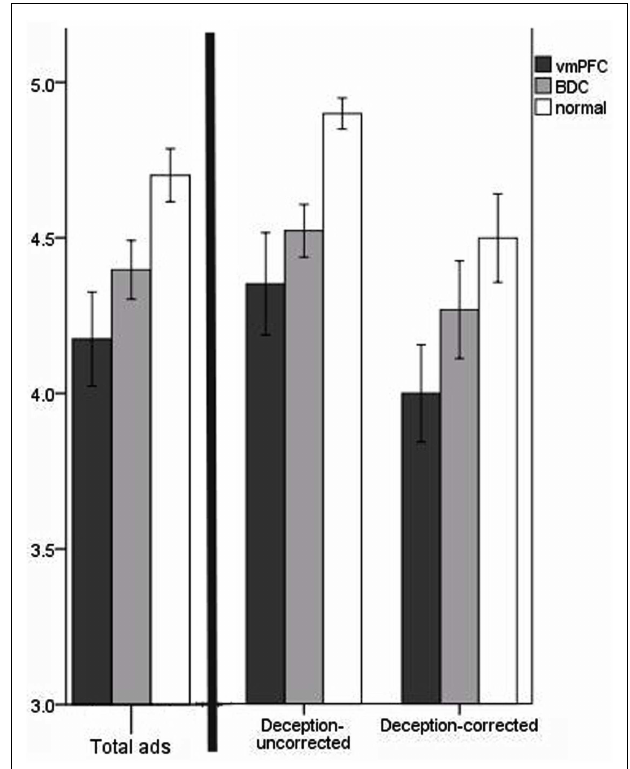
FIGURE 4 | Mean purchase intention scores for misleading ads. The scale is from 1 to 5 ( y -axis). Lower values reflect increased purchase intention for the products misleadingly advertised, and higher values reflect decreased purchase intention. Error bars indicate SEM.The graph on the left of the black bar represents results for all six misleading ads; the graph on the right of the black bar breaks the results down according to “deception-uncorrected” and “deception-corrected” ads. For all the ads, vmPFC patients had higher purchase intention than BDC patients and normal comparison participants for the products in the misleading